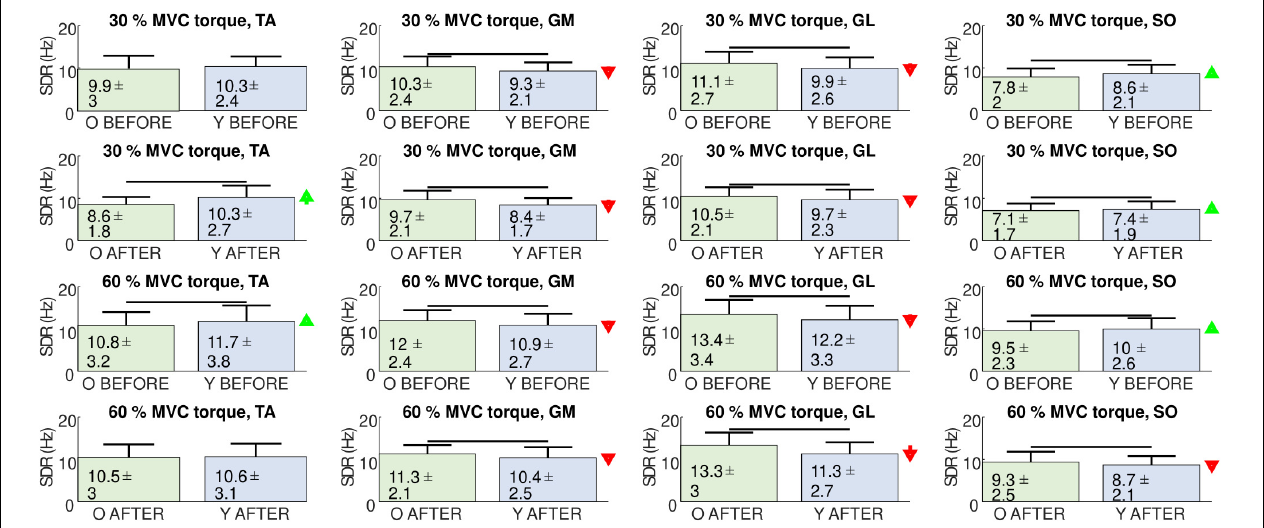
FIGURE 7 | Comparison of smoothed motor unit discharge rates (SDR, Mean ± SD) in the tibialis anterior (TA), gastrocnemius medialis (GM), gastrocnemius lateralis (GL), and soleus (SO) muscles between older (O), and young (Y) participants before (BEFORE), and after (AFTER) the bed rest. The red and green arrows indicate significant decrease and increase of SDR, respectively, at AFTER when compared to BEFORE (one-way ANOVA test, p <